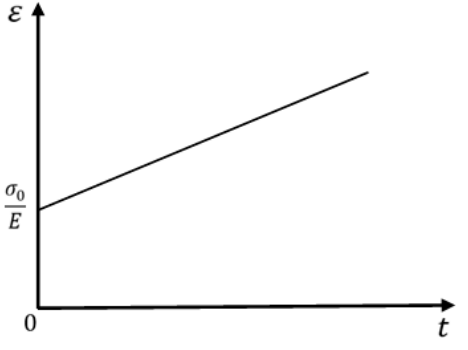
Figure 3. Maxwell creep model.